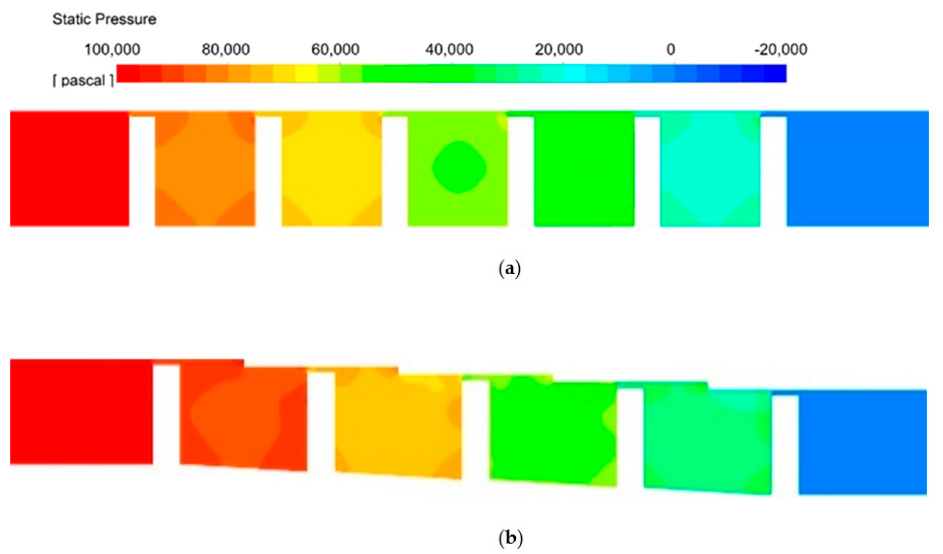
Figure 7. Contours of the labyrinth ‐ seal static pressure. ( a ) Straight ‐ through seal. ( b ) Stepped seal at SH*1.4.